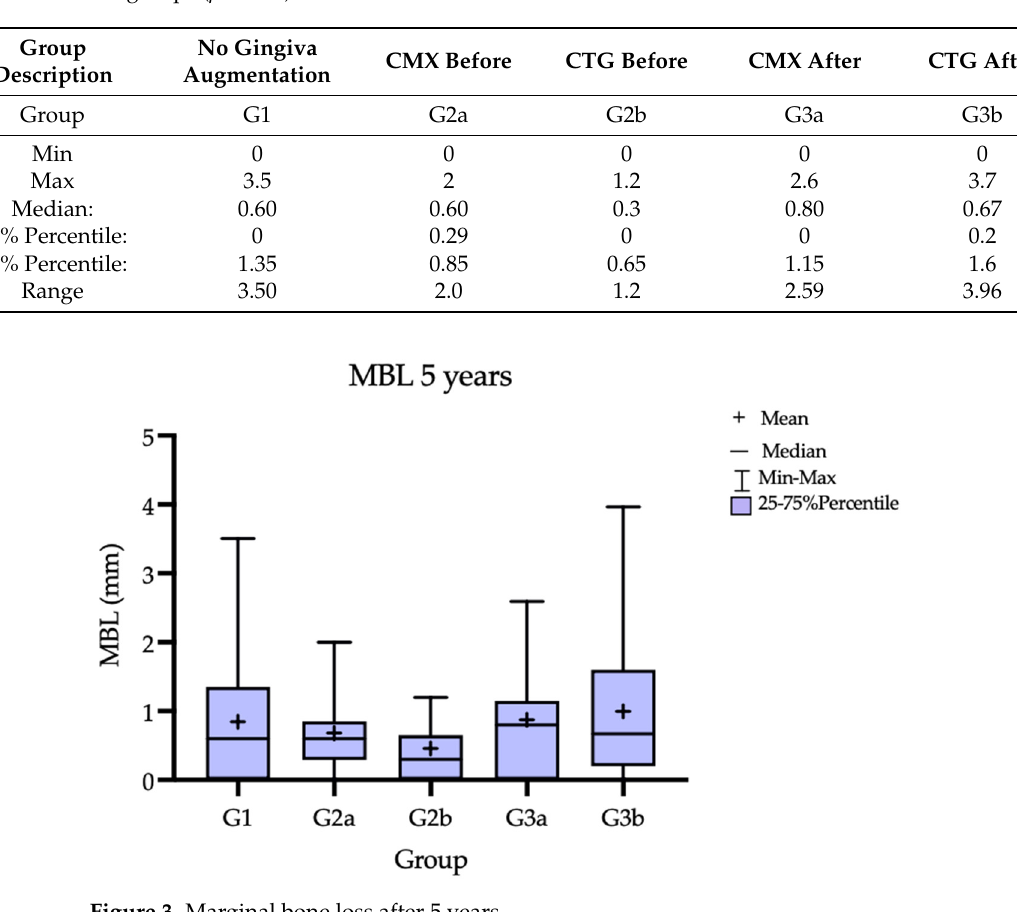
Figure 3. Marginal bone loss after 5 Table 1. Marginal bone loss after 5 years. No statistically significant differences were found between the groups ( p < 0.05).